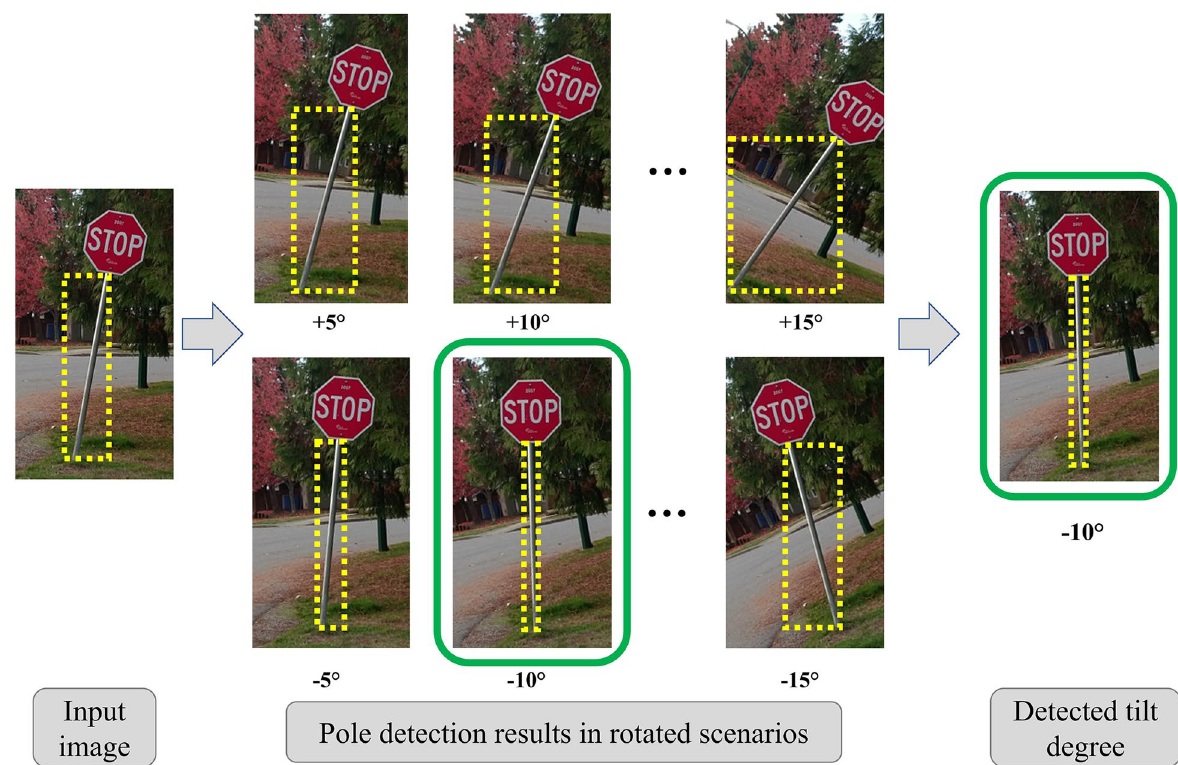
Fig. 5 Tilt detection approach (base photo is courtesy of